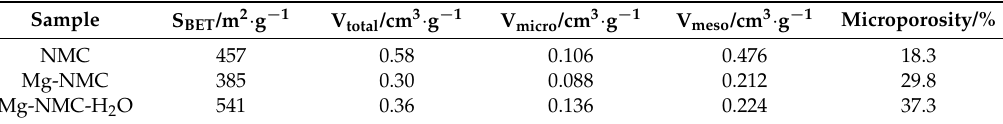
Figure 5. N 2 sorption isotherms ( a ) and pore size distribution plots ( b ) of NMC (solid triangles), Mg-NMC (solid circles) and Mg-NMC-H 2 O (open circles).